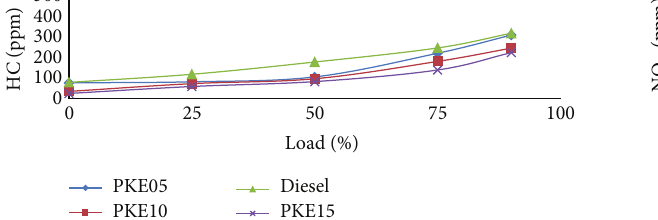
Figure 12: Load versus HC emissions at 19: 1 CR.